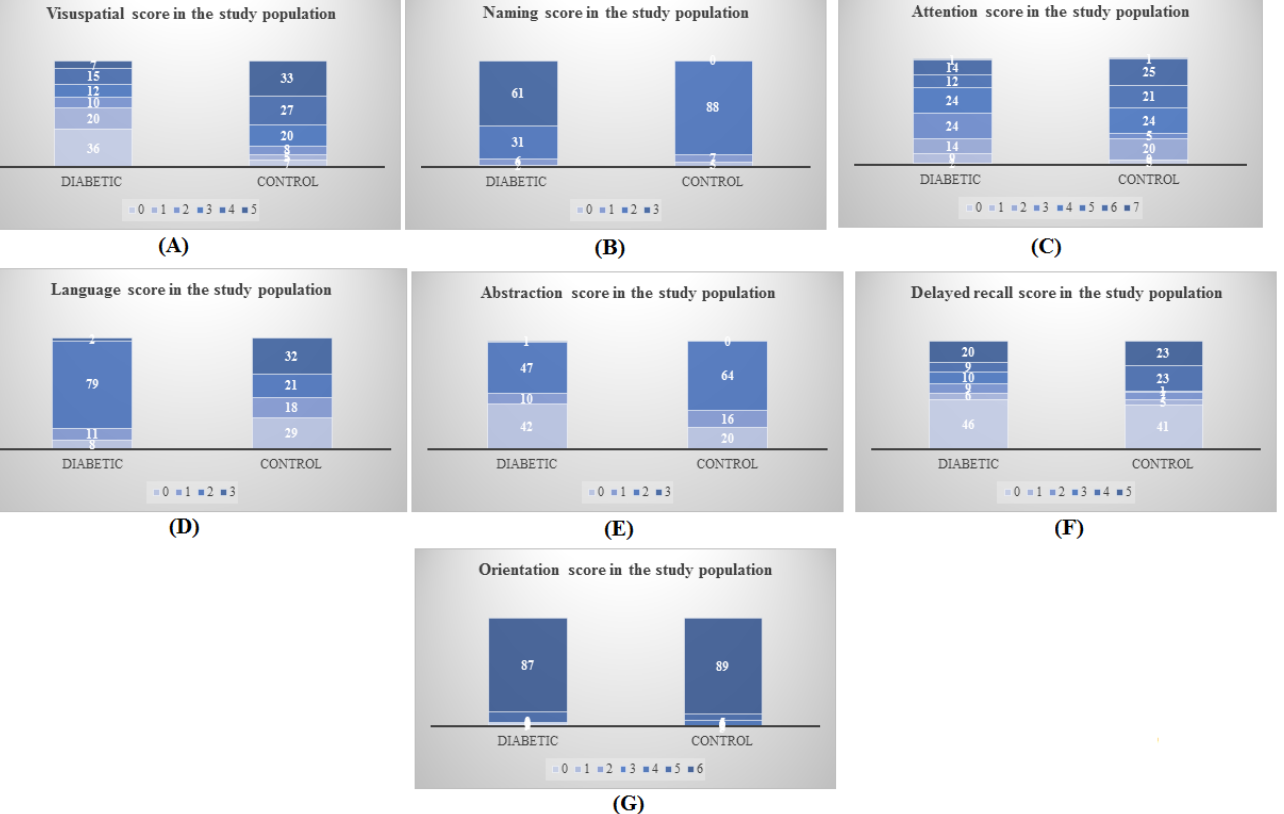
Figure 1. Subdomain scores in study subjects: ( A ) visuospatial score, ( B ) naming score, ( C ) attention score, ( D ) language score, ( E ) abstraction score, ( F ) delayed recall score, and ( G ) orientation score.